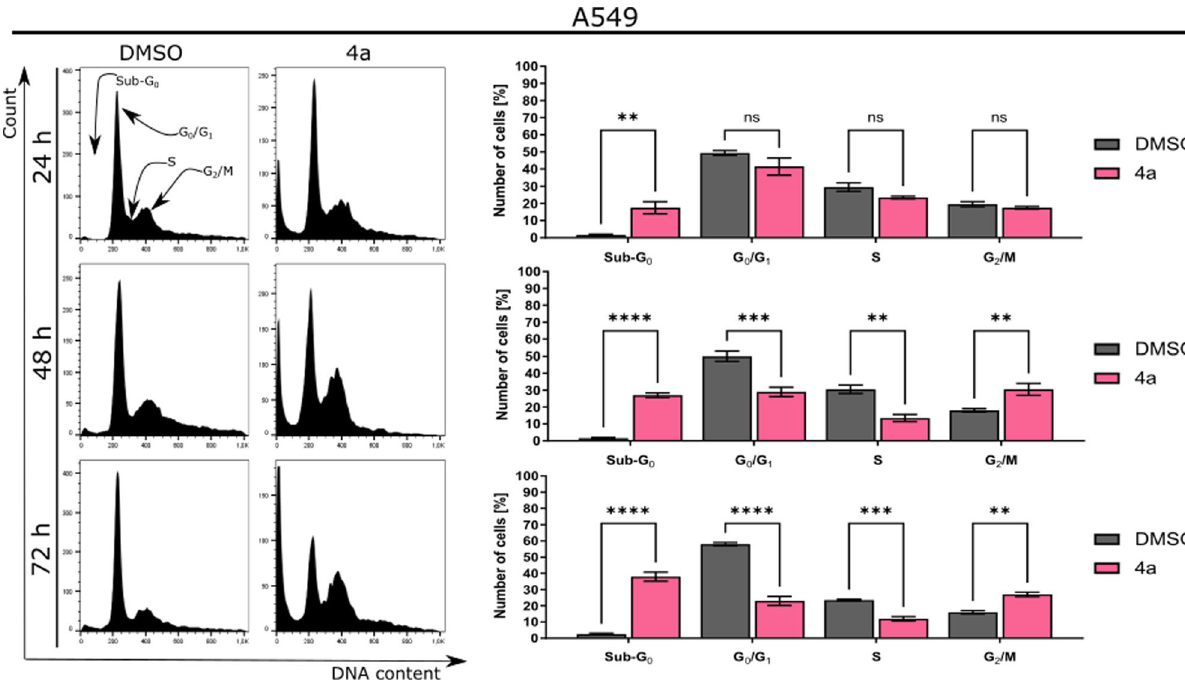
Figure 4. Analysis of cell cycle distribution after treatment of A549 cells with 4a . Data represent the mean ± SEM of n = 3 independent experiments. * p < 0.01, ** p < 0.001, *** p < 0.0001, and **** p <